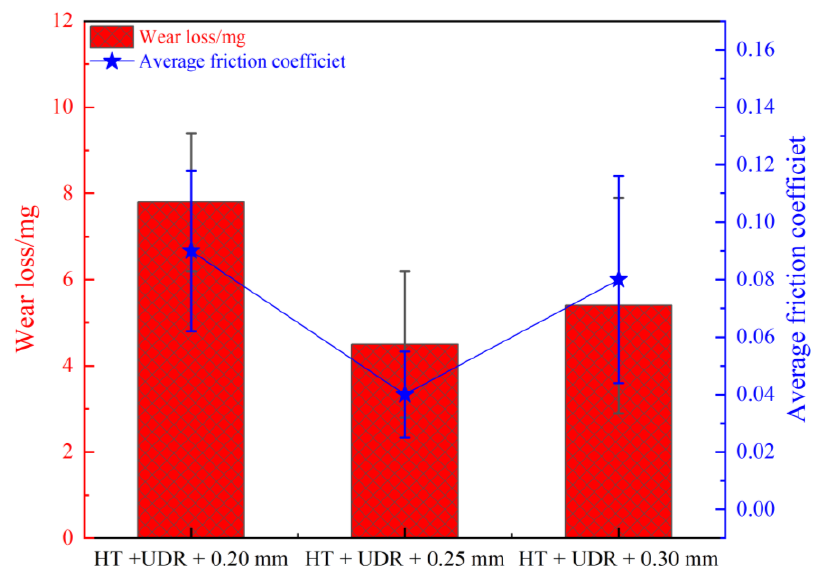
Figure 11. Average friction coefficient and wear of the coating under different preloading depths.